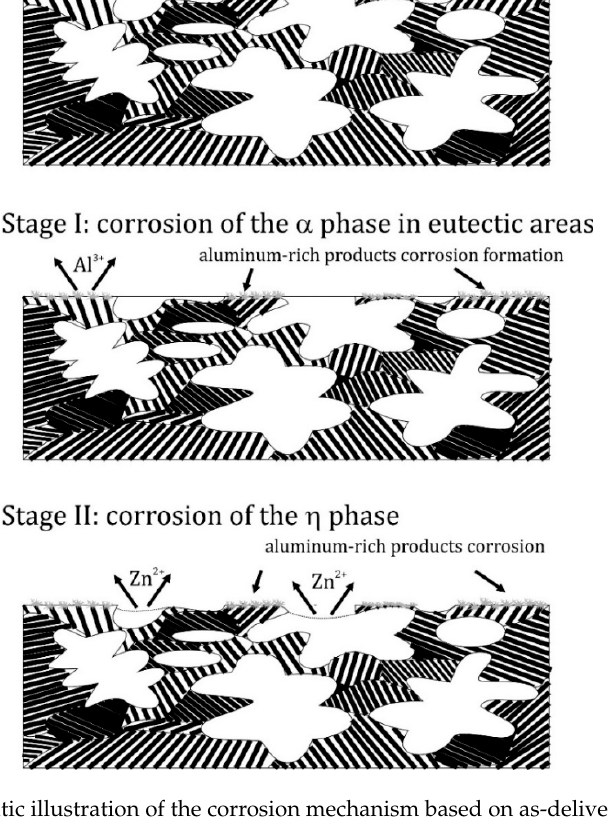
Figure 15. Schematic illustration of the corrosion mechanism based on as-delivered Zn-4Al alloy.